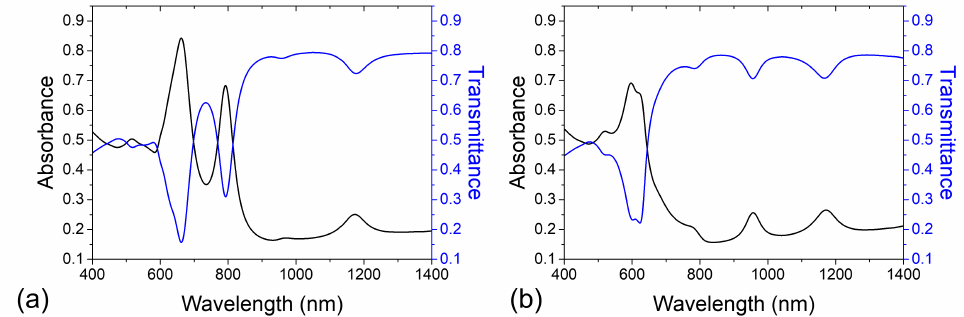
in the absorption mode, by varying the refractive index of the medium surrounding the helices, for values corresponding to 38% and 82% glycerol in water.